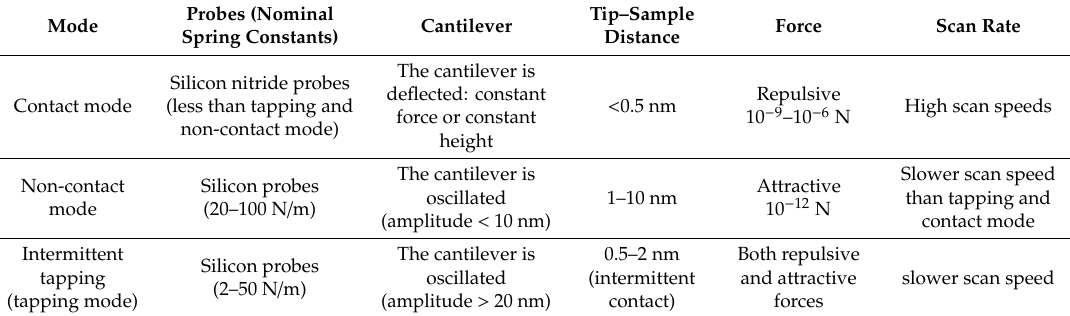
Table 1. Comparison of common operation modes of